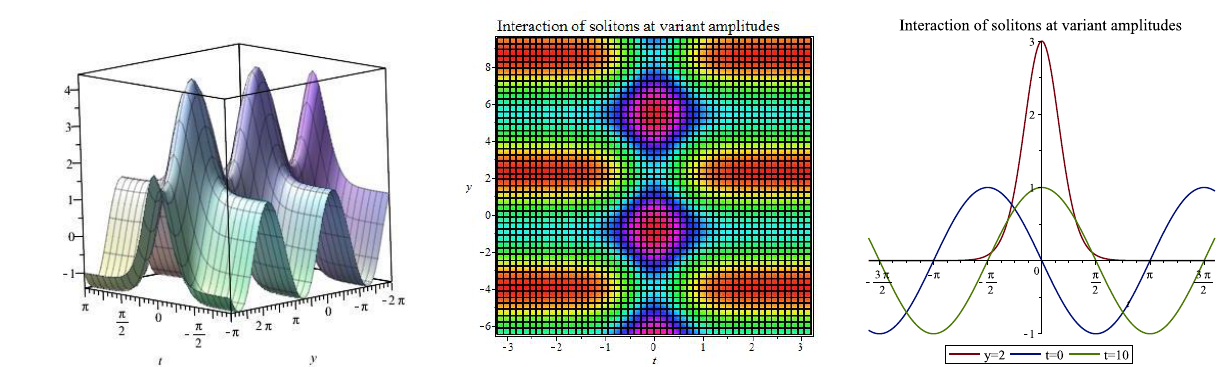
Figure 3. Wave depiction of soliton interaction with variant amplitudes at x =